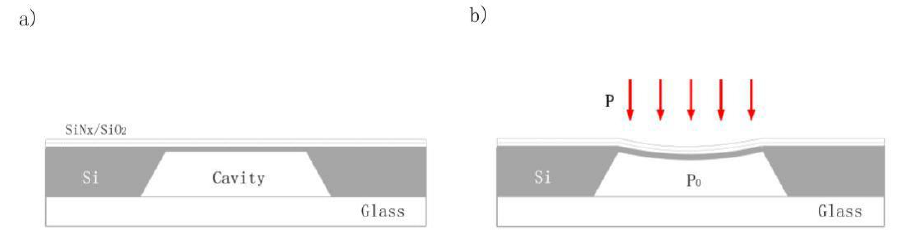
Figure 1. Schematic of the device: ( a ) basic structure of the device; ( b ) status of the device under the application of differential pressure.